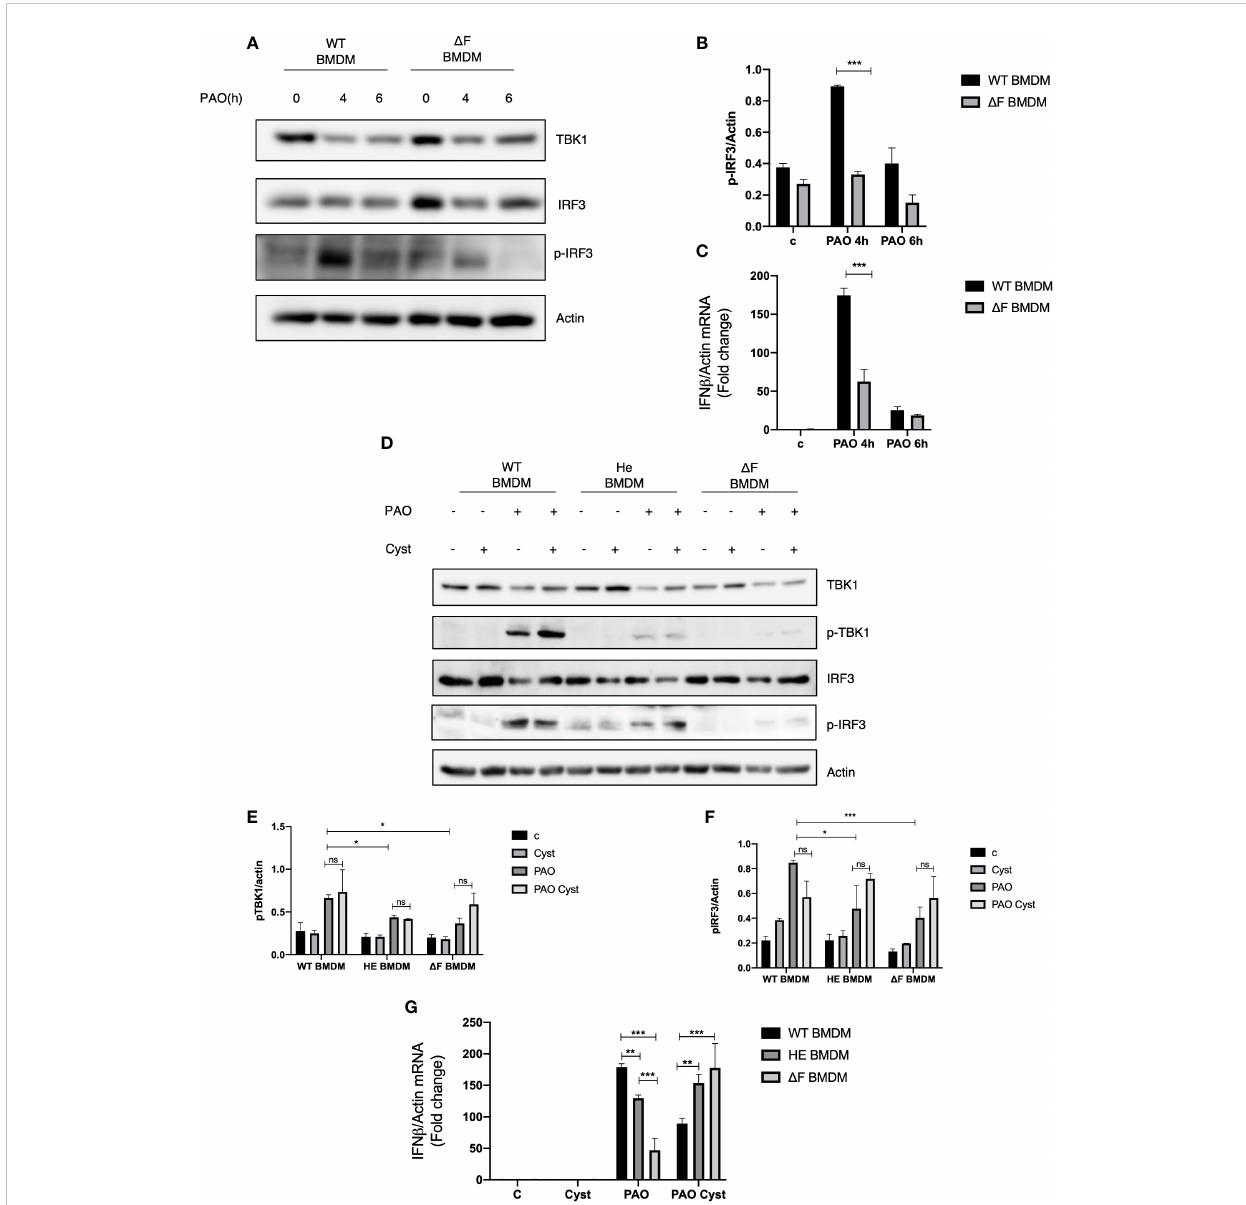
FIGURE 1 cGAS/STING pathway is downregulated in D F BMDMs (A) Western blot analysis of TBK1, IRF3 and p-IRF3 expression levels in WT and D F BMDMs after 4h and 6h infection with Pseudomonas aeruginosa strain (PAO-1). Actin was used as loading control. (B) Densitometric analysis showing p-IRF3 and actin expression levels in BMDMs following PAO-1 infection (n=3; means ± SEM; ***p<0.001). (C) IFN- b mRNA levels, quanti fi ed by qPCR, in BMDMs obtained from WT and D F mice after 4h and 6h infection with PAO-1, normalized to the mRNA levels of actin. (n=3; means ± SEM; ***p<0.001). (D) Western blot analysis of TBK1 and IRF3, and their phosphorylated forms, with their respective densitometric analysis (E, F) , in PAO-1 infected WT, HE and D F BMDMs following overnight cysteamine treatment. Actin was used to normalize protein loading levels. (n=3; means ± SEM; *p<0.05; ***p<0.001). (G) IFN- b mRNA expression levels, quanti fi ed by qPCR, in BMDMs treated with cysteamine, and infected with PAO-1 for 4h. Actin mRNA levels were used to normalize IFN- b mRNA levels. (n=3; means ± SEM; **p<0.01;